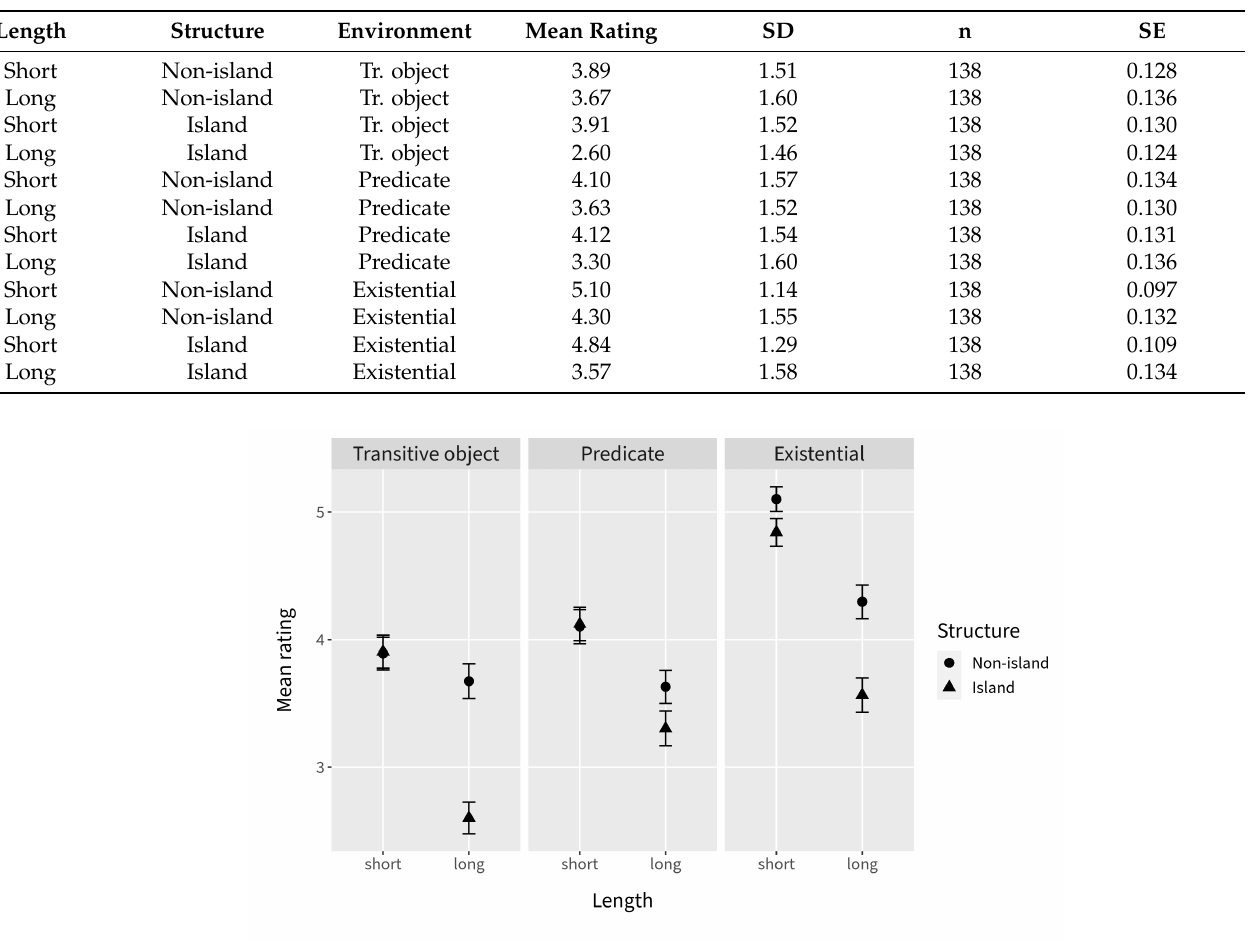
Figure 1. Mean ratings faceted by Environment, arranged in columns by Length. Error bars represent the standard error. Mean is calculated on raw (non-z-scored) ratings.